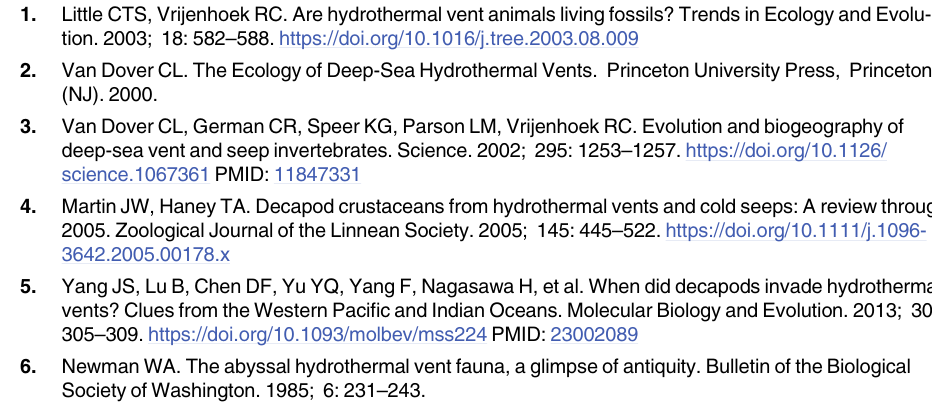
S1 Table. List of samples and their corresponding accession numbers included in the anal- yses in this study. S2 Table. M8a-M8 model analyses for each of the mitochondrial PCGs and the concatenated data sets. S3 Table. Branch-site model analyses of the gene-specific mitochondrial data sets.